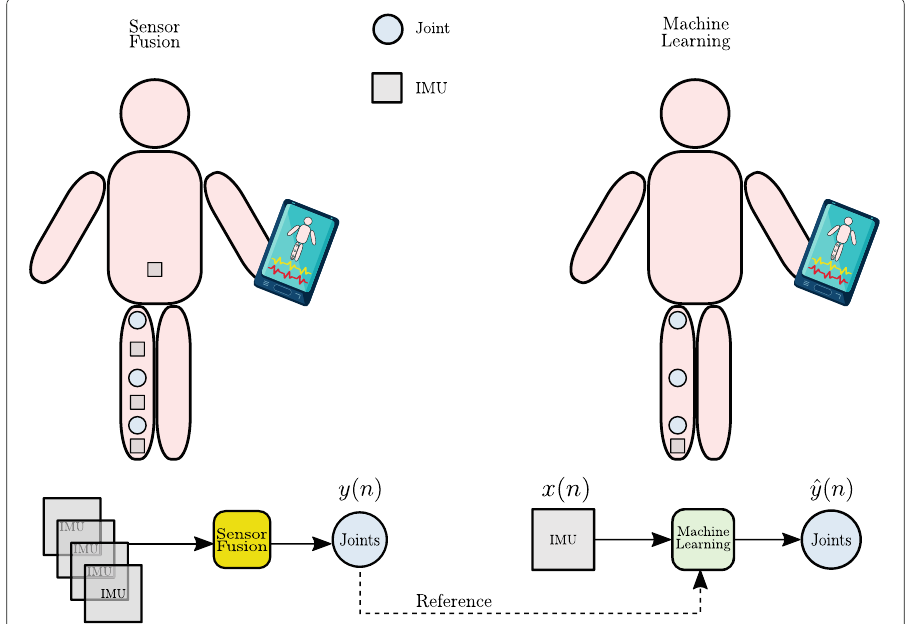
Fig. 1 Wearable system concept: the gait kinematic data x ( n ) are collected and processed with machine learning methods in the Android application for digital and biomedical healthcare systems. On the left side, the traditional sensor fusion algorithm based on KF estimates the lower limb joint signals using the information from four IMUs. On the right side, the novel machine learning approach estimates the lower limb joint angles based on the information of only one IMU placed on the foot. The dashed line represents the reference data y ( n ) for the training and test phases of the different machine learning (ML)